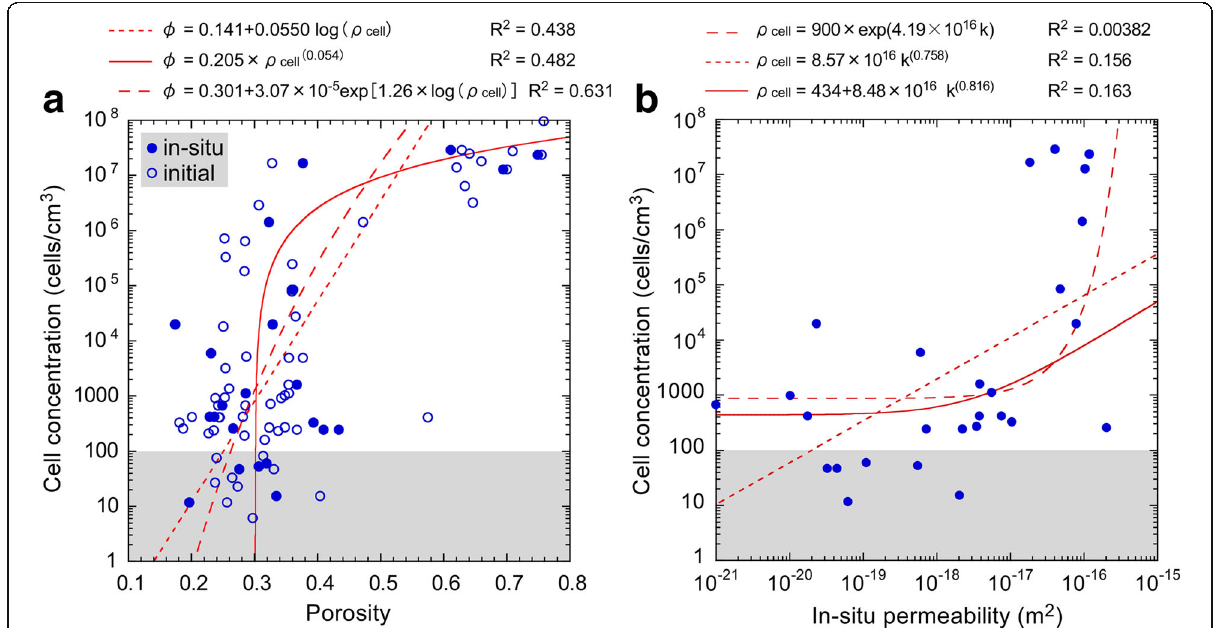
Fig. 6 Relationship between cell density and in-situ physical properties and their semi-empirical curves: a in-situ porosity and b in-situ permeability. Cell concentrations at depths closest to the depths where physical properties were measured (0.79±0.68 m and 0.89±0.68 m apart for ( a ) and ( b ), respectively). Gray shading indicates cell concentrations below the minimum quantification limit. Fits estimated by the least squares method using in-situ values and the errors are also shown. The initial porosity data is modified from Inagaki et al. (2012). Φ : porosity, ρ cell : cell density (cells/cm 3 ),